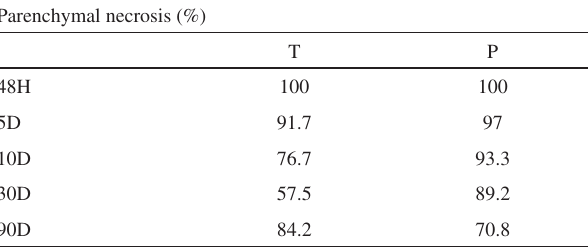
treated kidneys in both groups (T and P) 48 hours after embolization. In the animals that were sacrificed at later time points, the ischemic lesions and infarctions were more prominent in the group P rabbits, specifically 30 days after embolization (Table 4). Table 4 - Average percentage of parenchymal necrosis related to the time elapsed since embolization with either trisacryl (T) or PVAc